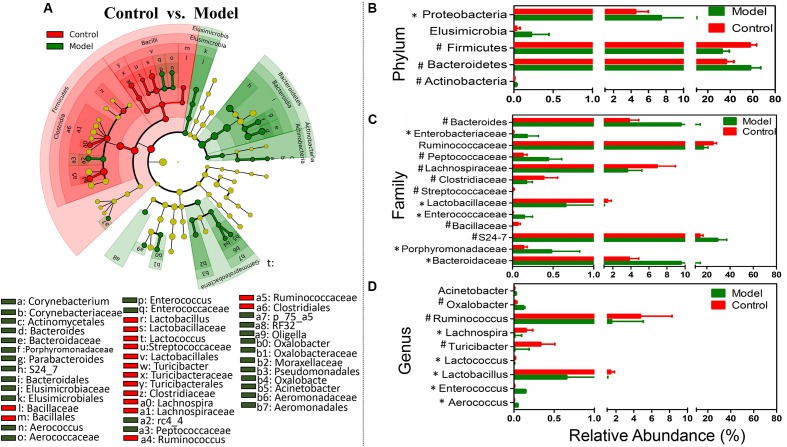
Taxonomic differences of fecal microbiota between the control group and the model group. (A) Differentially abundant microbial cladogram obtained by LEfSe, the brightness of each dot is proportional to its effect size. Comparison of relative abundance at the phylum (B), family (C), and genus (D) levels between the control group and the model group; all the differences were analyzed using Mann–Whitney U test; ∗P < 0.05; #P < 0.01.